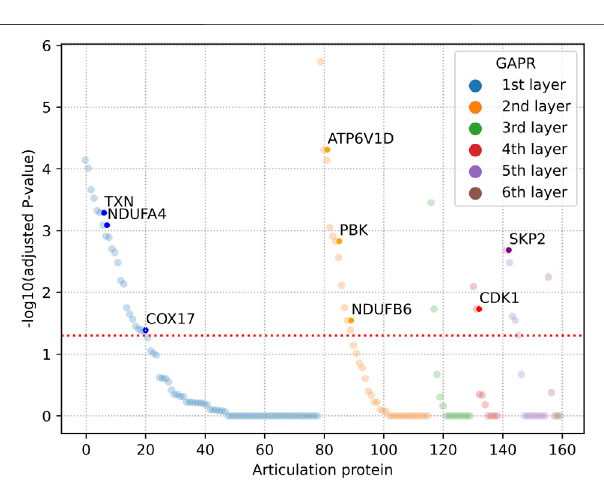
FIGURE 5 | Dysregulated articulation proteins in vitiligo. The adjusted p -value was calculated by one-side Wilcoxon rank sum test and Benjamini- Hochberg method. GAPR: Greedy articulation points